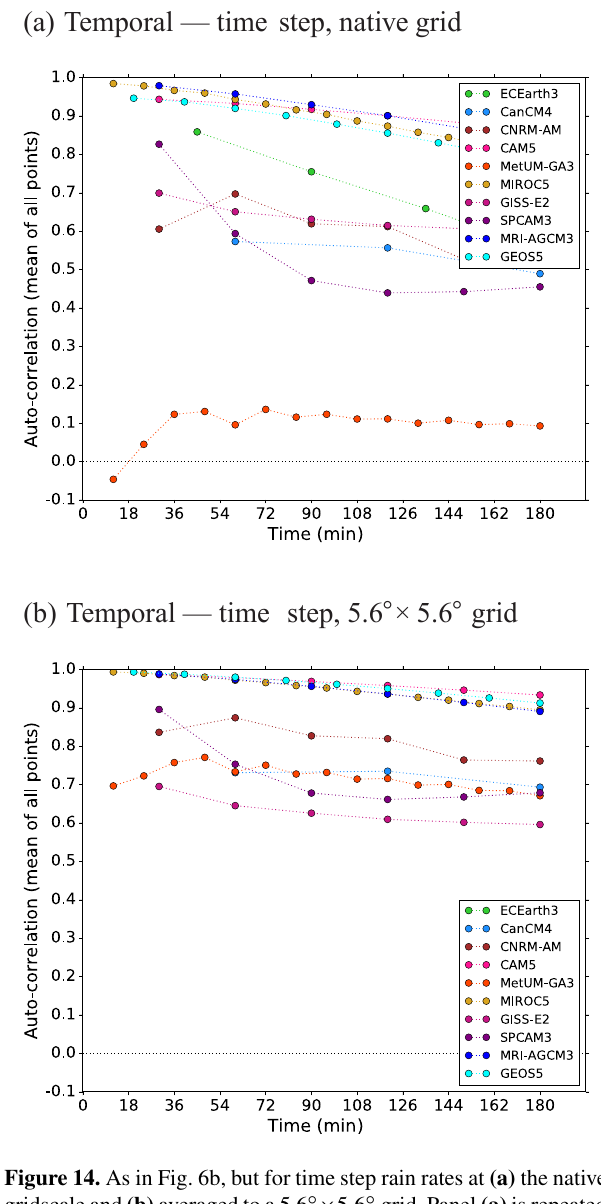
Figure 14. As in Fig. 6b, but for time step rain rates at (a) the native gridscale and (b) averaged to a 5.6 ◦ × 5 . 6 ◦ grid. Panel (a) is repeated from Fig. 6b for ease of